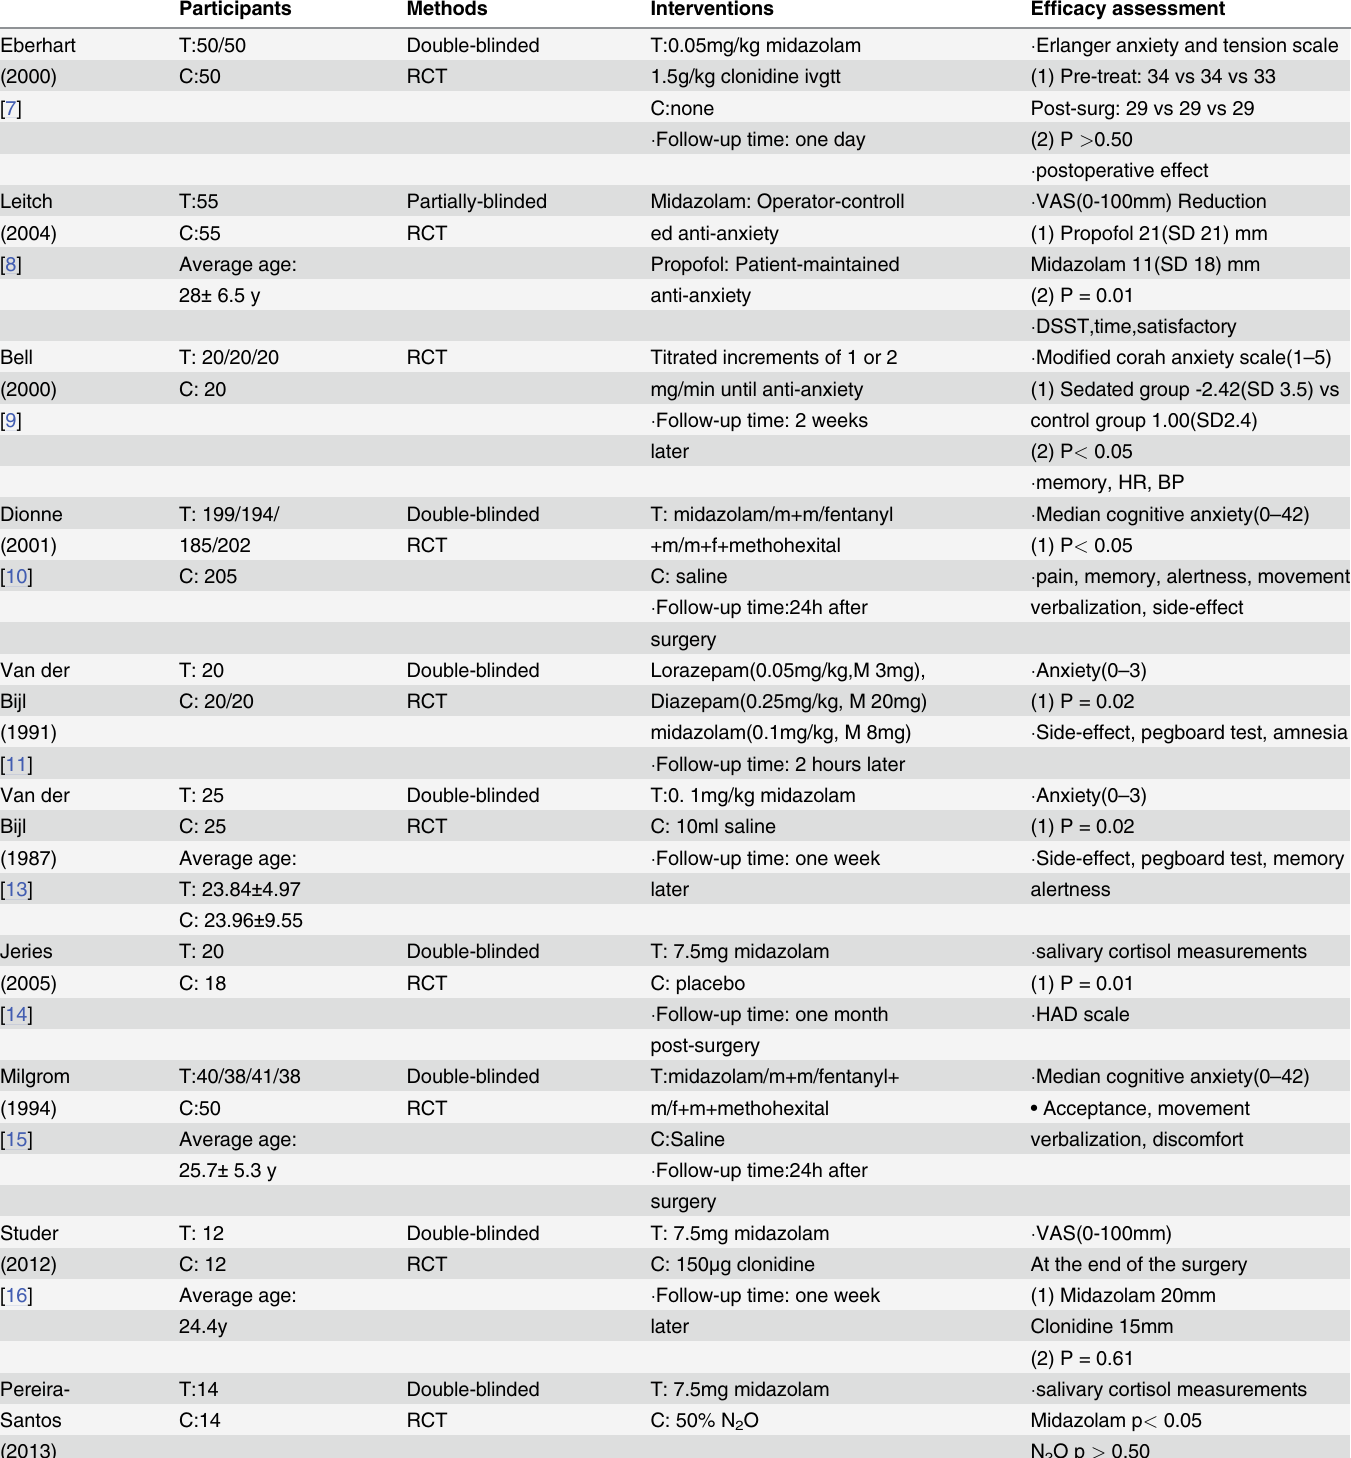
Table 1. Characteristics of included